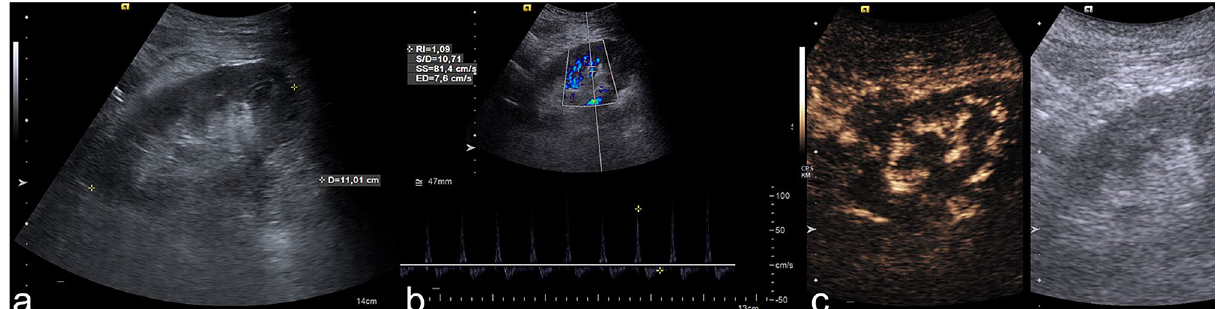
Figure 4. Delimitation of RVT compared to RCN. CEUS examination of a 55-year-old man with renal vein thrombosis. ( a ) The B-mode image shows signs of poor corticomedullary differentiation. ( b ) The pulsed wave (PW) spectrum shows triphasic flow with a resistance index of 1.1, suggesting disturbed venous outflow. ( c ) CEUS (after 50 s) shows no contrast enhancement (indicating loss of microcirculation) of the renal cortex and medullary pyramids. In the cine loop, a pulse-synchronous “pushing” of the microbubbles in the interlobar arteries is visible without cortical enhancement. RVT denotes renal vein thrombosis; CEUS, contrast-enhanced ultrasound, PW, pulsed wave Doppler sonography, RCN, renal cortical